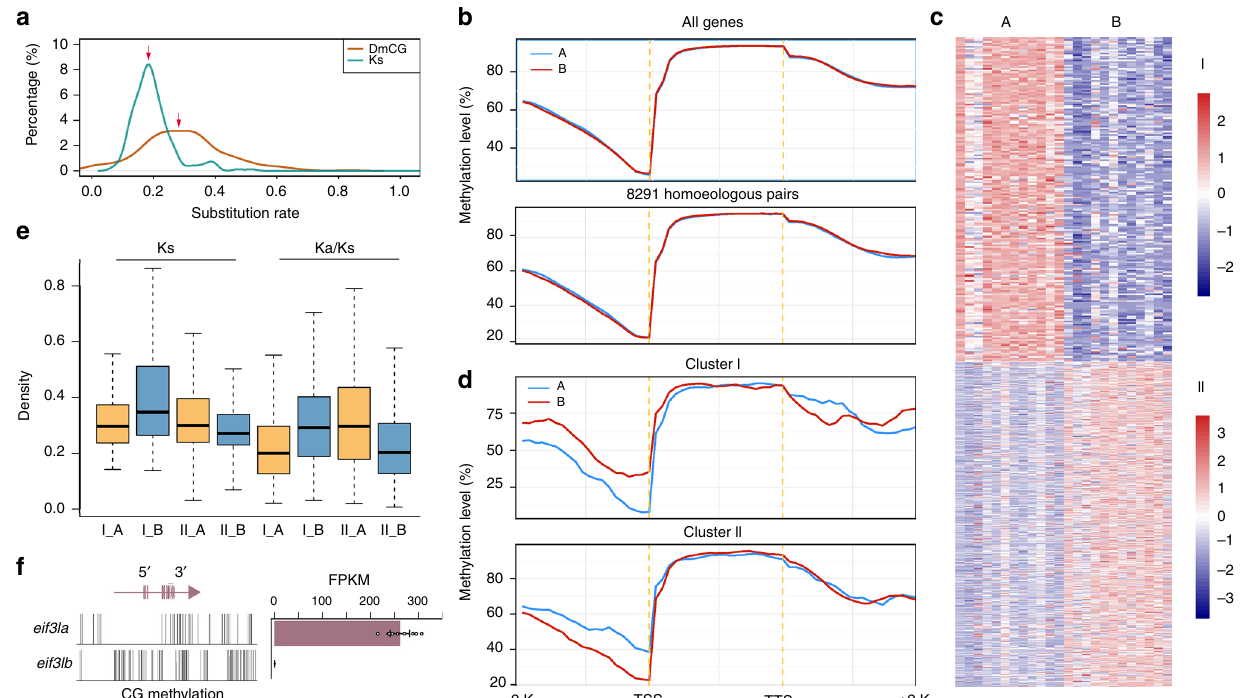
Fig. 4 DNA methylation in homoeologous expression bias in C. carpio . a Distribution of synonymous substitution values (Ks) (blue) and gene-body DmCG percentages (red) of 2393 methylated homoeologous genes. Peak values are indicated by arrows. b CG methylation levels of all annotated genes and 8291 homoeologous gene pairs in two subgenomes. c Heatmaps of two extremely divergent co-expression clusters, of which one of two homoeologous genes in subgenomes A or B was extensively transcribed while the other copies suppressed in 12 tissues. d CG methylation levels of divergent expressed homoeologous genes corresponding to clusters I and II in c . e Boxplot of the Ka/Ks ratio distribution of homoeologous genes of two extremely divergent expression clusters in two subgenomes as shown in c . Yellow and blue boxplots indicate the genes in subgenomes A or B, respectively. f CG methylation level and expression level of homoeologous genes eif3I of C. carpio , which demonstrated that reduced CG methylation levels in the promotor region correlated with increased expression levels of eif3Ia , while eif3Ib was heavily methylated and silenced. FPKM reads per kilobases per million. Data represent mean ± sem for n = 9 expressed